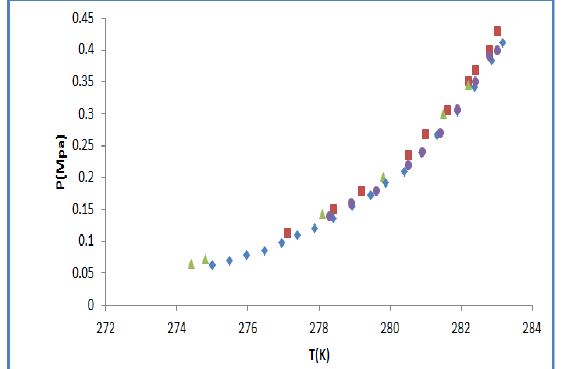
Fig. 7. Experimental data for R134a hydrate